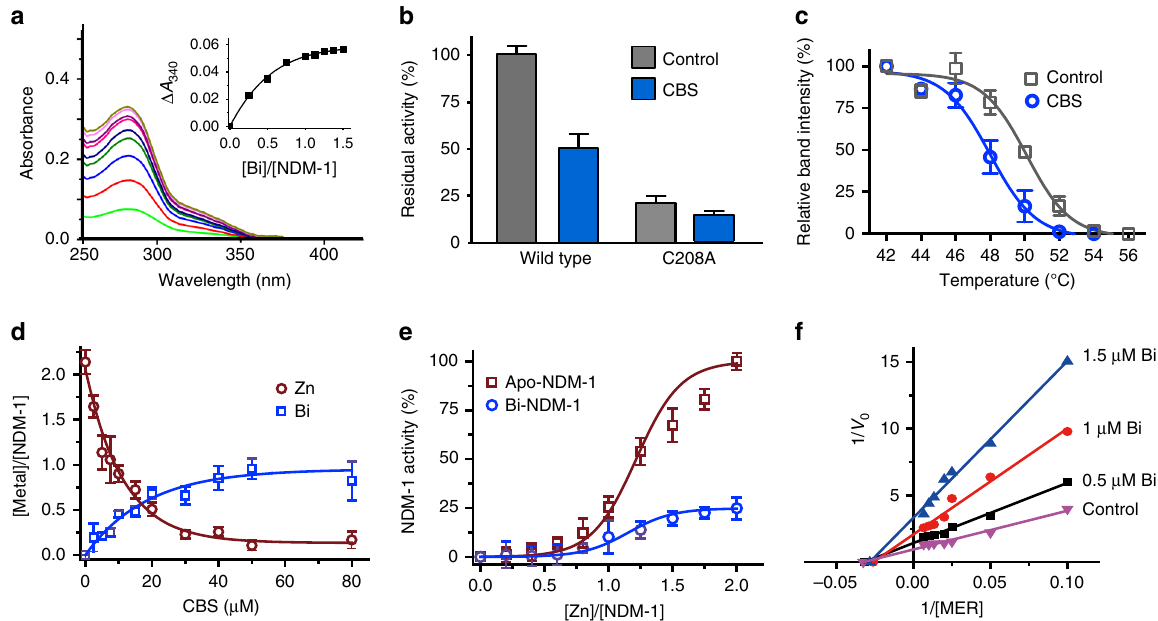
Fig. 2 Bi(III) compounds inhibit the activity of MBLs via a unique metal replacement mechanism. a Different UV-vis spectra of apo-NDM-1 upon addition of 0.2 – 1.5 molar equivalents of Bi(NTA). The inset shows the changes of absorbance at 340 nm. b Normalized residual activity of wild-type (WT) NDM-1 and a variant of NDM-1-C208A in the absence or presence of CBS at IC 50 . c Cellular thermal shift assays showing the binding of Bi(III) to NDM-1 in E. coli as judged from the shift of NDM-1 melting temperature from 50.1 °C to 48 °C for control and CBS-treated group, respectively. Mean value of three replicates are shown and error bars indicate SD. d The substitution of Zn(II) in NDM-1 by CBS as determined by ICP-MS. e Restoration of activity of NDM-1 upon supplementation of various ratios of Zn(II) to apo-NDM-1 and Bi-NDM-1. Mean value of three replicates are shown and error bars indicate SD. f The Lineweaver Burk plot shows that Bi(III) (as Bi(NIT) 3 ) inhibited NDM-1 via either a non-competitive or an irreversible inhibition